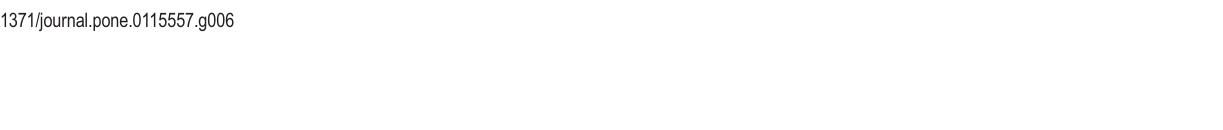
PLOS ONE | DOI:10.1371/journal.pone.0115557 February 2,